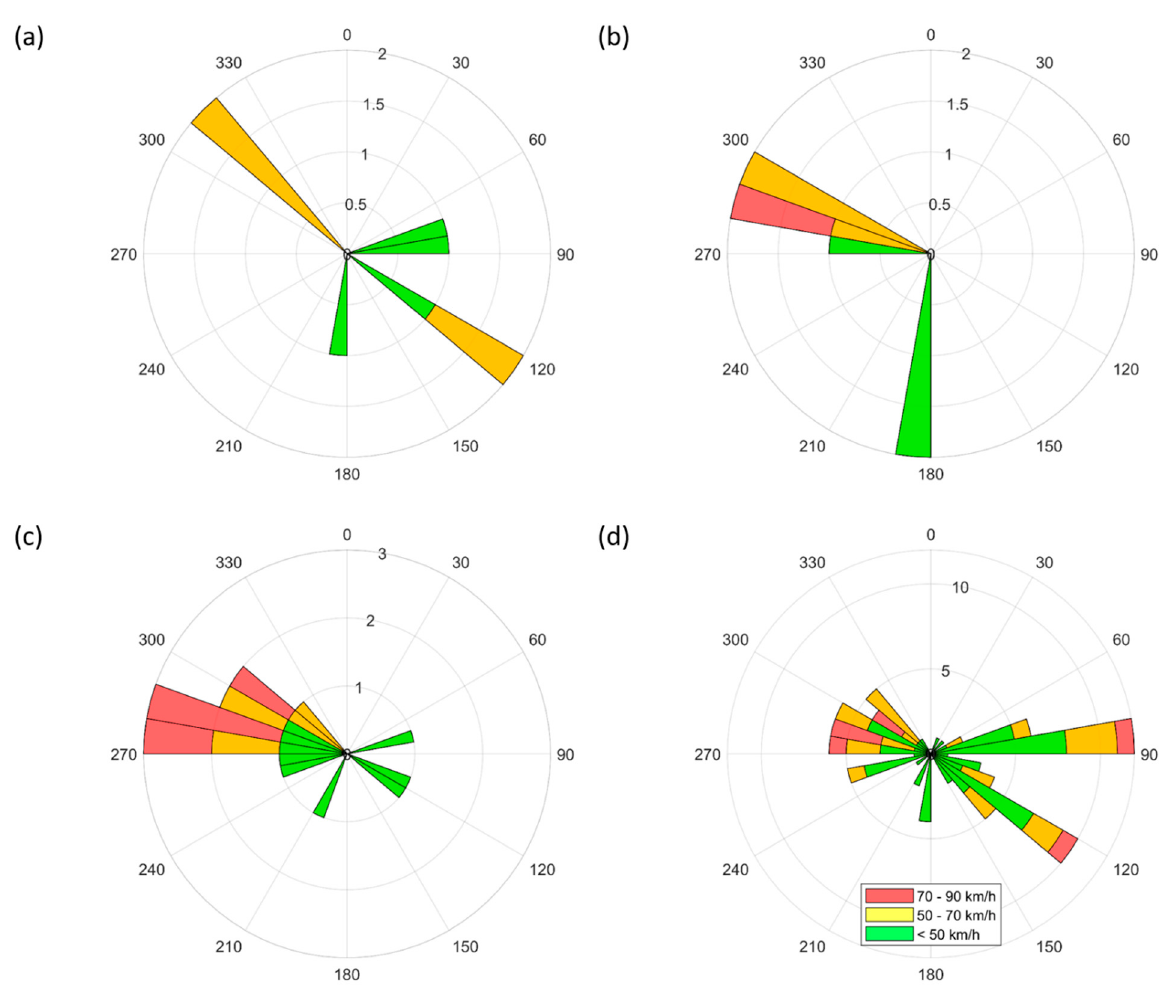
Figure 6. Wind rose diagrams from the Pelly Island station during 20180113–20180125 ( a ), 20180125–20180206 ( b ),